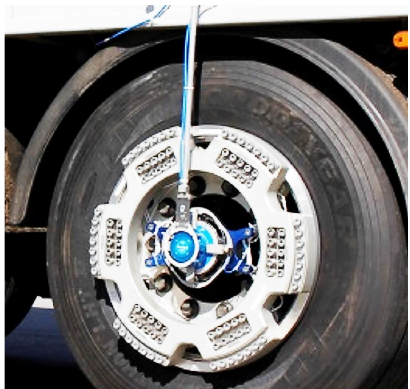
Fig. 3. Wheel force transducers